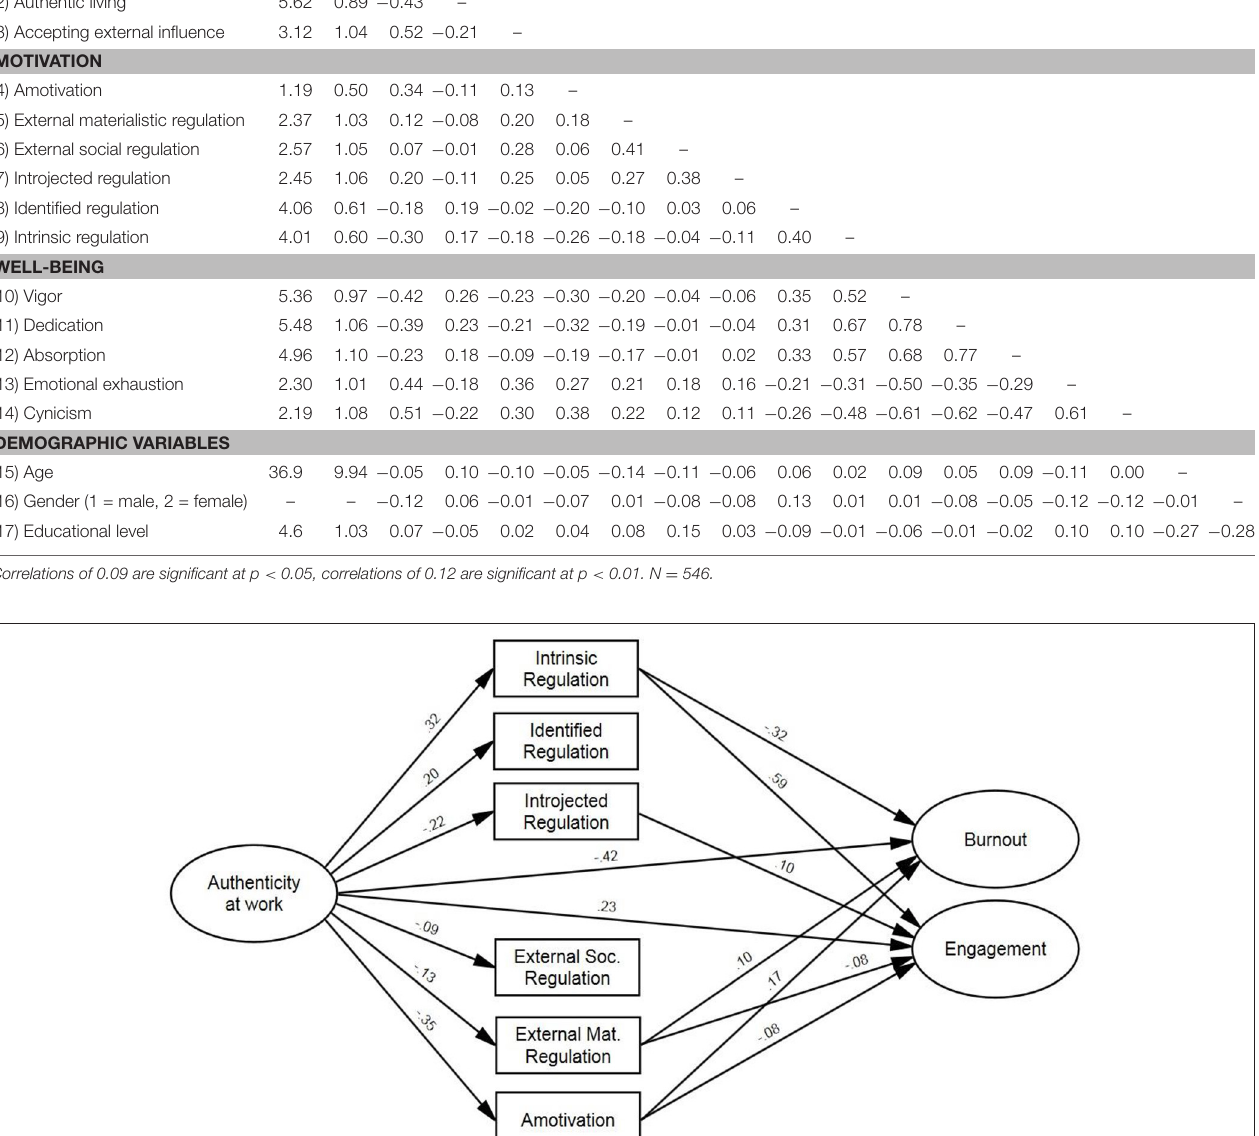
(Hypothesis 4d), and amotivation (Hypothesis 4e),